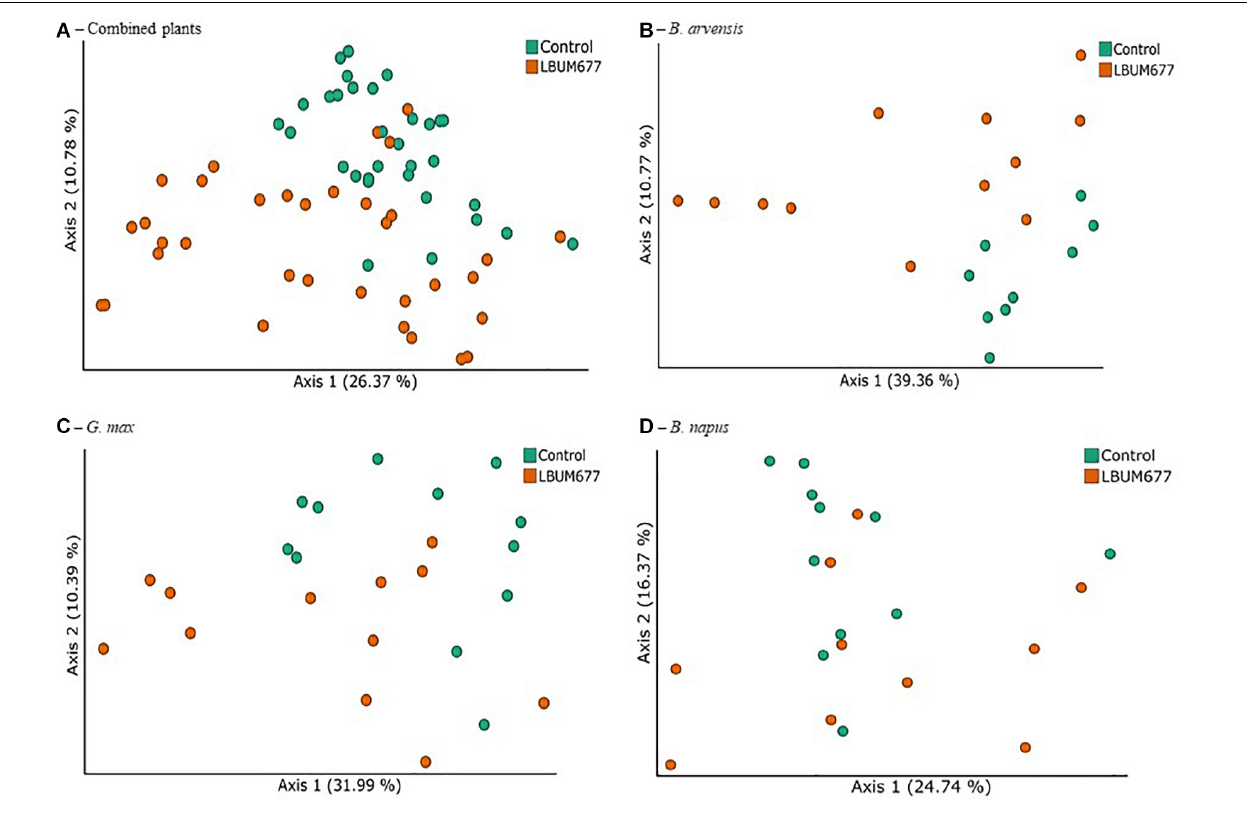
FIGURE 6 | Treatment variations of beta-diversity metrics in the bacterial microbiome of three oil-producing crops. (A) PCoA plot representative of treatment beta-diversity variations using weighted UniFrac metric for all plants and sampling dates combined ( F = 5.51, p = 0.001). Each point represents a sample, (B) PCoA plot representative of treatment beta-diversity variations using weighted UniFrac metric for all B. arvensis plants and sampling dates combined ( F = 3.20, p = 0.011). Each point represents a sample, (C) PCoA plot representative of treatment beta-diversity variations using weighted UniFrac metric for all G. max plants and sampling dates combined ( F = 2.41, p = 0.021). Each point represents a sample, and (D) PCoA plot representative of treatment beta-diversity variations using weighted UniFrac metric for all B. napus plants and sampling dates combined ( F = 1.52, p = 0.106). Each point represents a